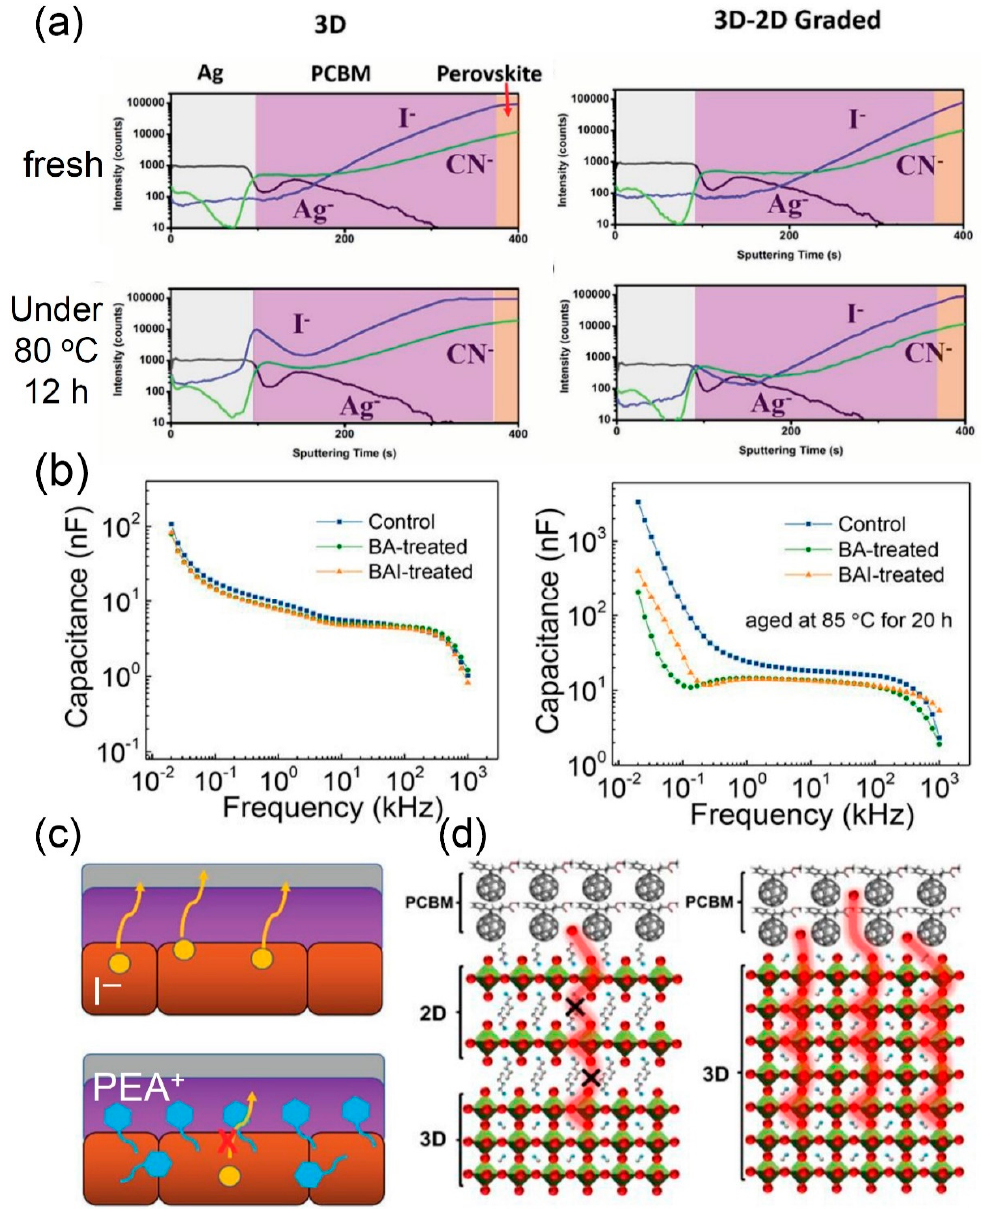
Figure 9. Thermal-induced ion migration in perovskite films. ( a ) Time-of-flight secondary ion mass spectroscopy (ToF-SIMS) depth-profile of relative elements of fresh and aged PSC devices with 3D (left) and 3D/2D (right) under 80 °C for 12 h. ( b ) Capacitance change of the devices based on 3D and 2D (n-butylamine (n-BA) and n-butyl ammonium iodide (n-BAI)) under thermal stress at 85 °C for 20 h. ( c ) Illustration of general ion migration in a 3D-based device (top) and suppressed ion migration in a 3D/2D-based device (bottom). ( d ) Illustrations of the inhibited escape of amine gas (MA) ions in 3D/2D perovskite (left) and MA volatilization in 3D perovskite (right) under thermal stress. Reprinted with permission from Ref. [44] Copyright 2017 WILEY–VCH for ( a ) and ( c ). Reprinted with permission from Ref. [36] Copyright 2018 American Chemical Society for ( b ) and ( d ).